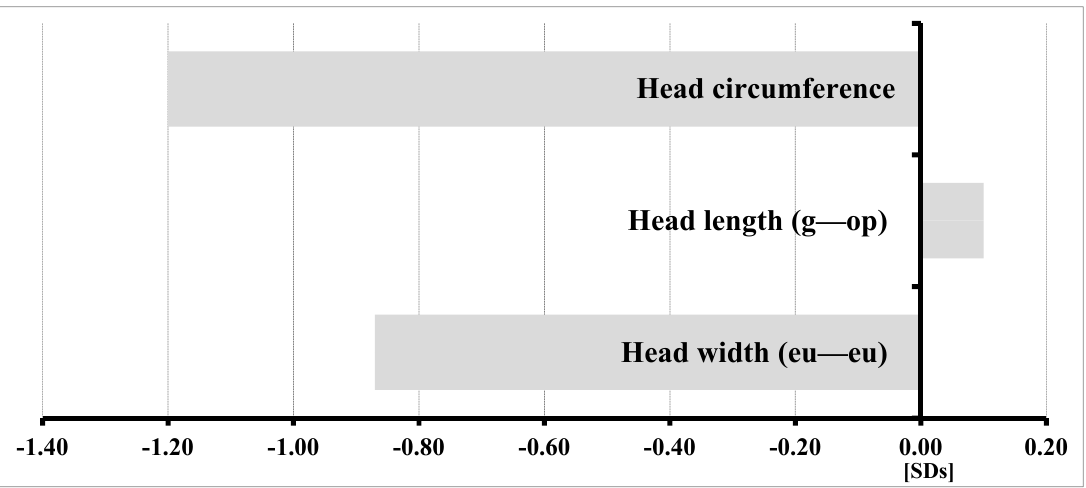
Figure 2. Profile of the mean normalized head characteristics of all examined children with KBG syndrome. The head measurements of the patients were narrower ( − 0.87 SDs), longer (0.10 SDs) and smaller in circumference ( − 1.20 SDs) in comparison with the reference group. The standard deviations of the assessed data were within the normal range.